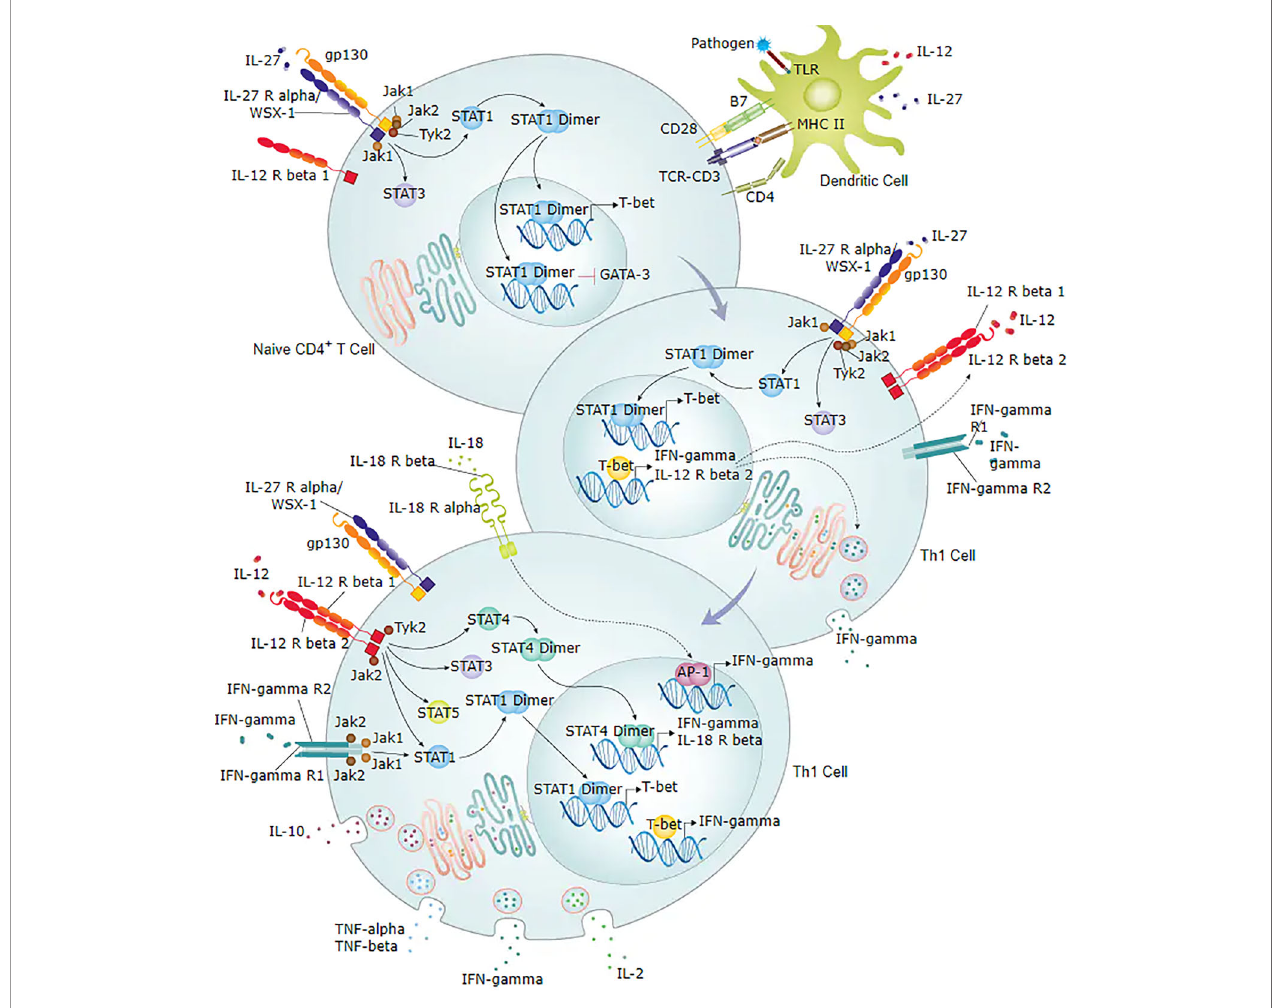
FIGURE 7 | Diagram of IFN- g involved in Th1/Th2 cell differentiation signalling pathway. Figure obtained from